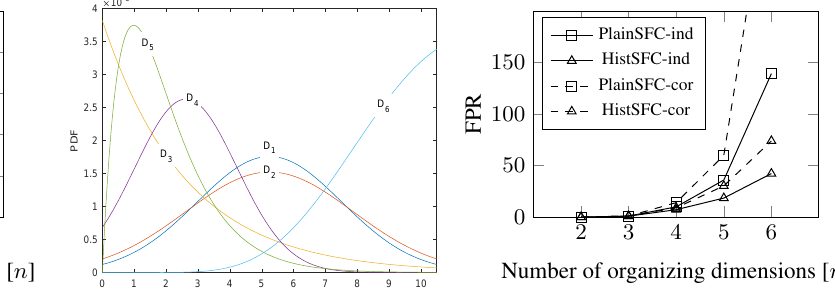
Figure 11. Mean FPR for 2- n D query in